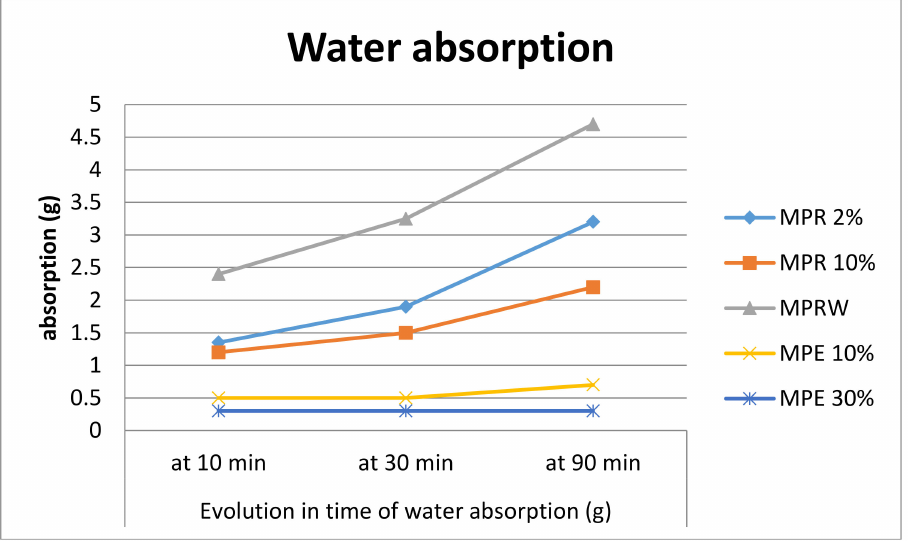
Figure 5. Graphical representation of water absorption at 10, 30, and 90 min for the mortars MPR 2%, MPR 10%, MPRW, MPE 10%, MPE 30%.